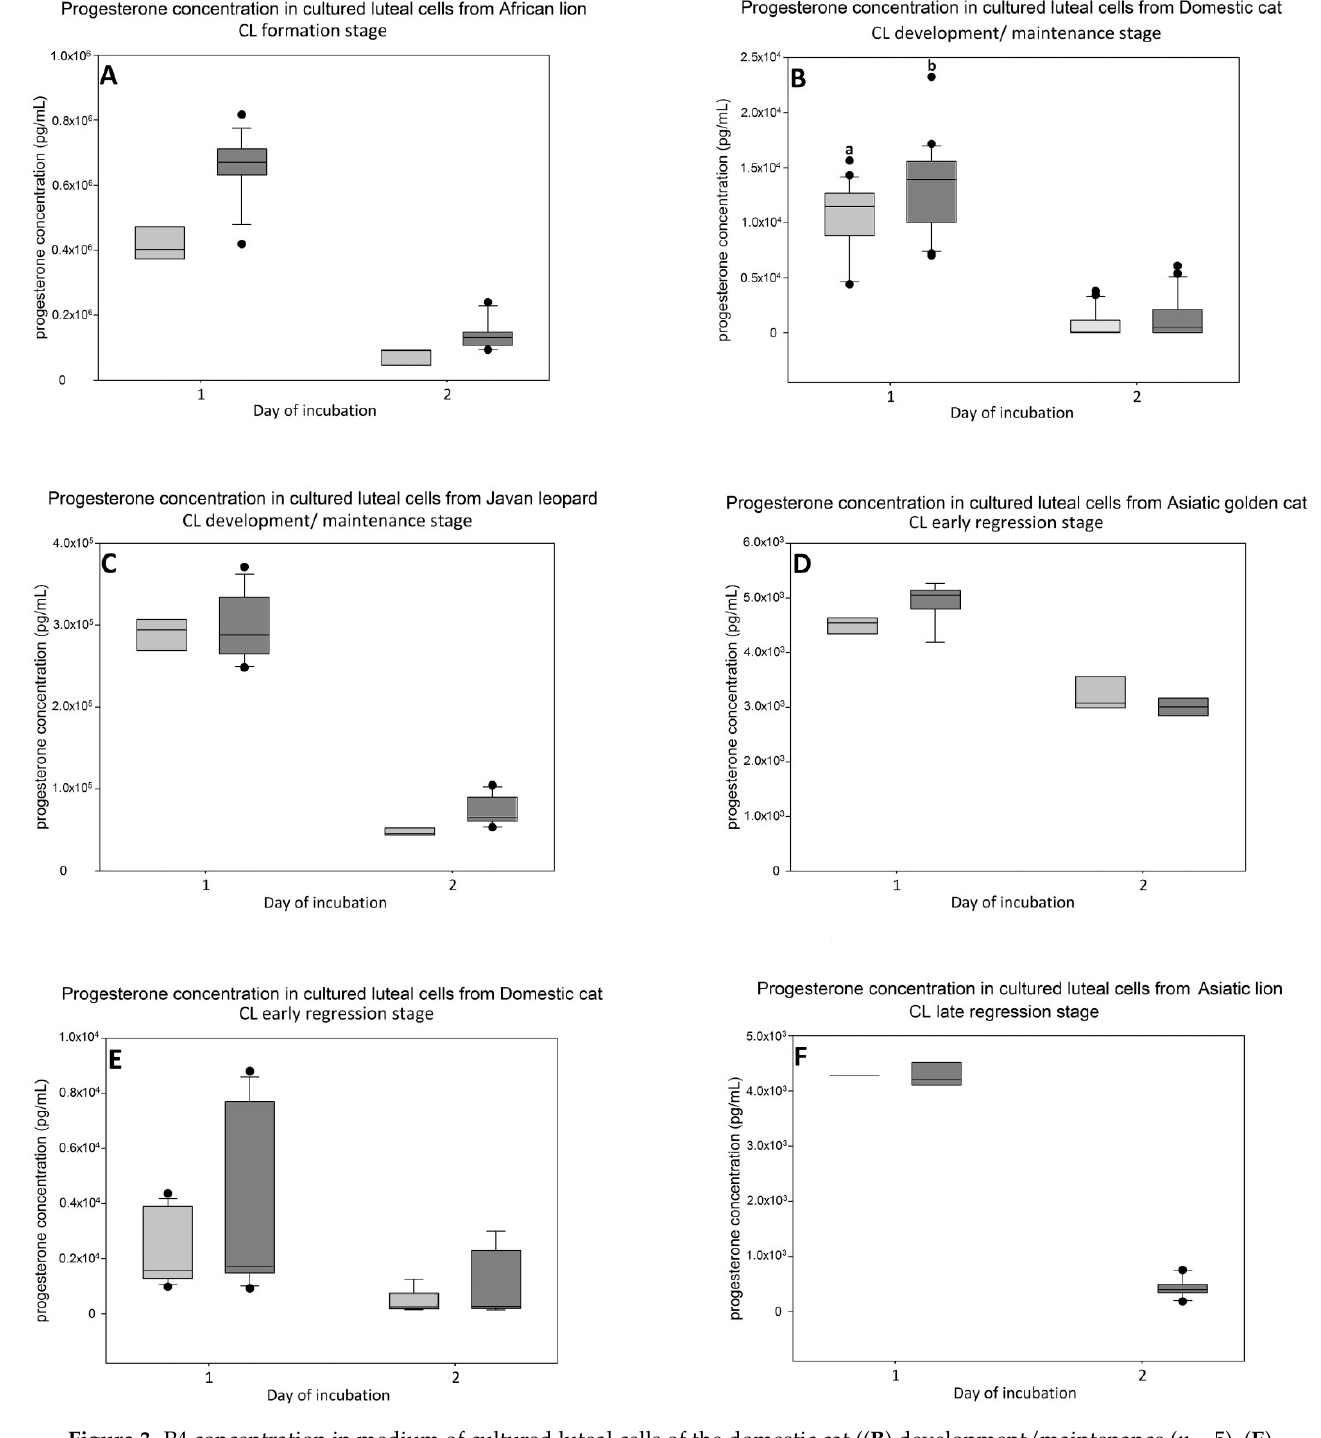
Figure 3. P4 concentration in medium of cultured luteal cells of the domestic cat (( B ) development/maintenance ( n = 5), ( E ) early regression ( n = 3)) and wild felid species at different CL stages (( A ) African lion ( n = 1), formation; ( C ) Javan leopard ( n = 1), development/maintenance; ( D ) Asiatic golden cat ( n = 1), early regression; ( F ) Asiatic lion ( n = 1), late regression) showed as box plots of median (horizontal line), 25th and 75th percentiles (lower/upper end of box) and 10th and 90th percentiles (whiskers); black dots indicate outliers. Light grey—control group, grey—LH 100 ng/mL group. Statistical Mann–Whitney was applied only on samples from the domestic cat. Small letters indicate statistically significant different groups ( p < 0.05) at the same day of incubation. In the cell culture of the Asiatic lion, progesterone concentration in the control group at day 2 was not measured because of limited number of cells.